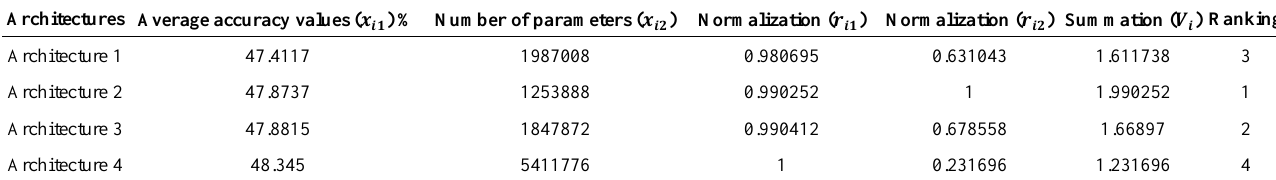
Table 4. Normalization results for the first stage of the AMIGOS dataset